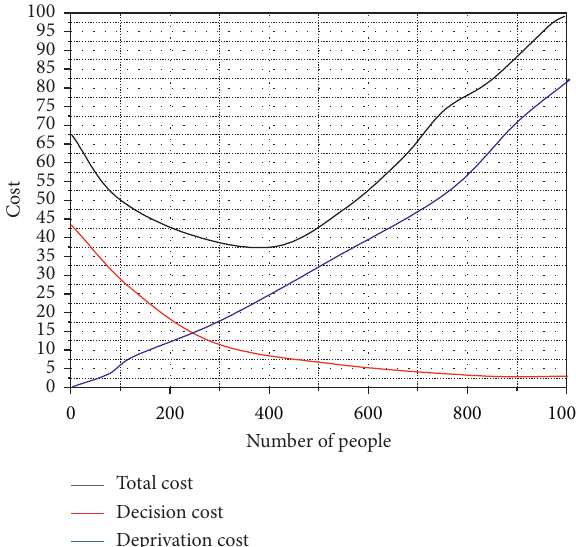
practical group